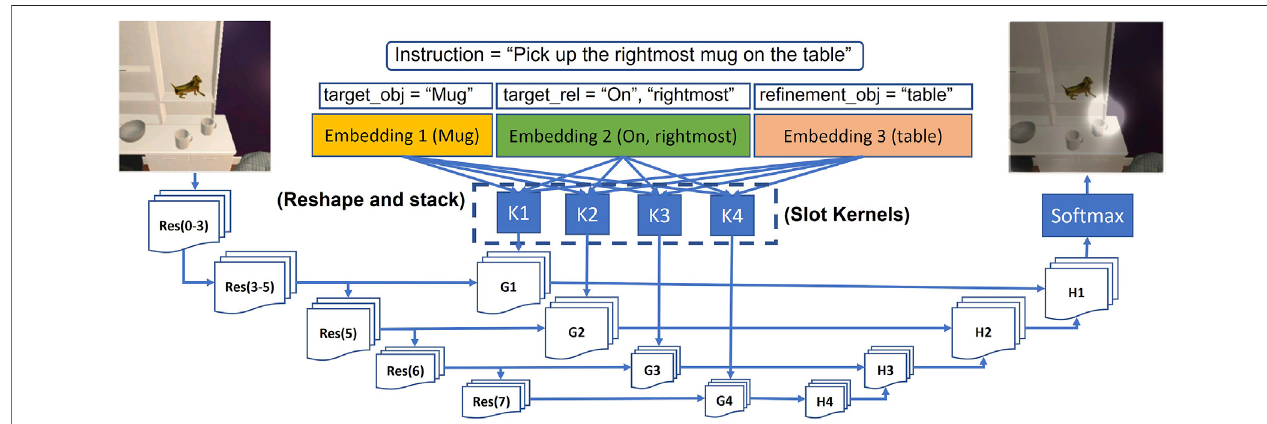
FIGURE8| Cross-Modalgroundingframeworkadapted fromLingUNet. Res(i-j)denotes pretrainedlayersofResNetstartingfromlayernumberitolayernumber j. Output of softmax is intersected with output of UNet based class segmentation map to arrive at fi nal map.